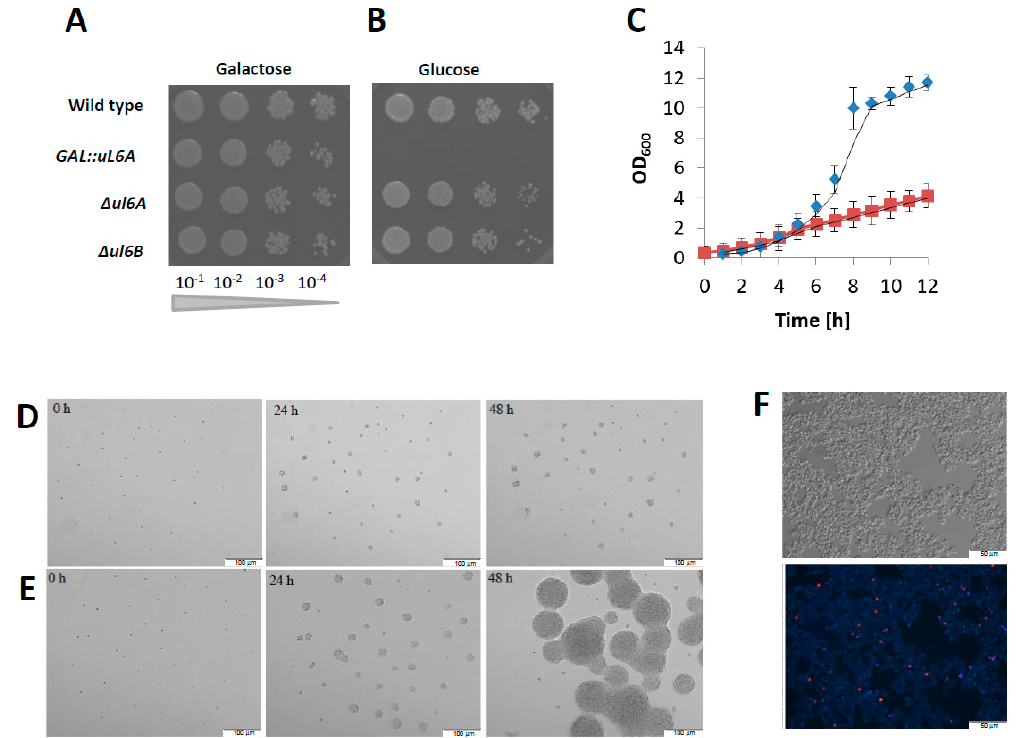
Figure 2. Growth of uL6 mutant yeast strains on various carbon sources. ( A , B ) Cells of the Δ ul6A, Δ ul6B , and GAL::uL6A mutants and the wild type were spotted onto agar plates with YPD (Glucose) or YPGal (Galactose) medium as indicated and incubated at 30 °C for 3 days. ( C ) Growth curves of GAL::uL6A (red squares) and wild type (blue diamonds) strains at 30 °C after shifting exponential cultures from liquid YPGal to liquid YPD medium. The optical density (OD 600 ) of the cultures was measured at different time points for up to 12 h. Error bars represent standard deviations obtained from three independent experiments. ( D – F ) Effects of depletion of both uL6A and uL6B on the budding ability and viability. GAL::uL6A mutant cells were grown on YPD ( D ) or YPGal ( E ) plates, and cell growth was monitored under the microscope after 0 h, 24 h, and 72 h. ( F) Propidium iodide staining of GAL::uL6A budding yeast cells.